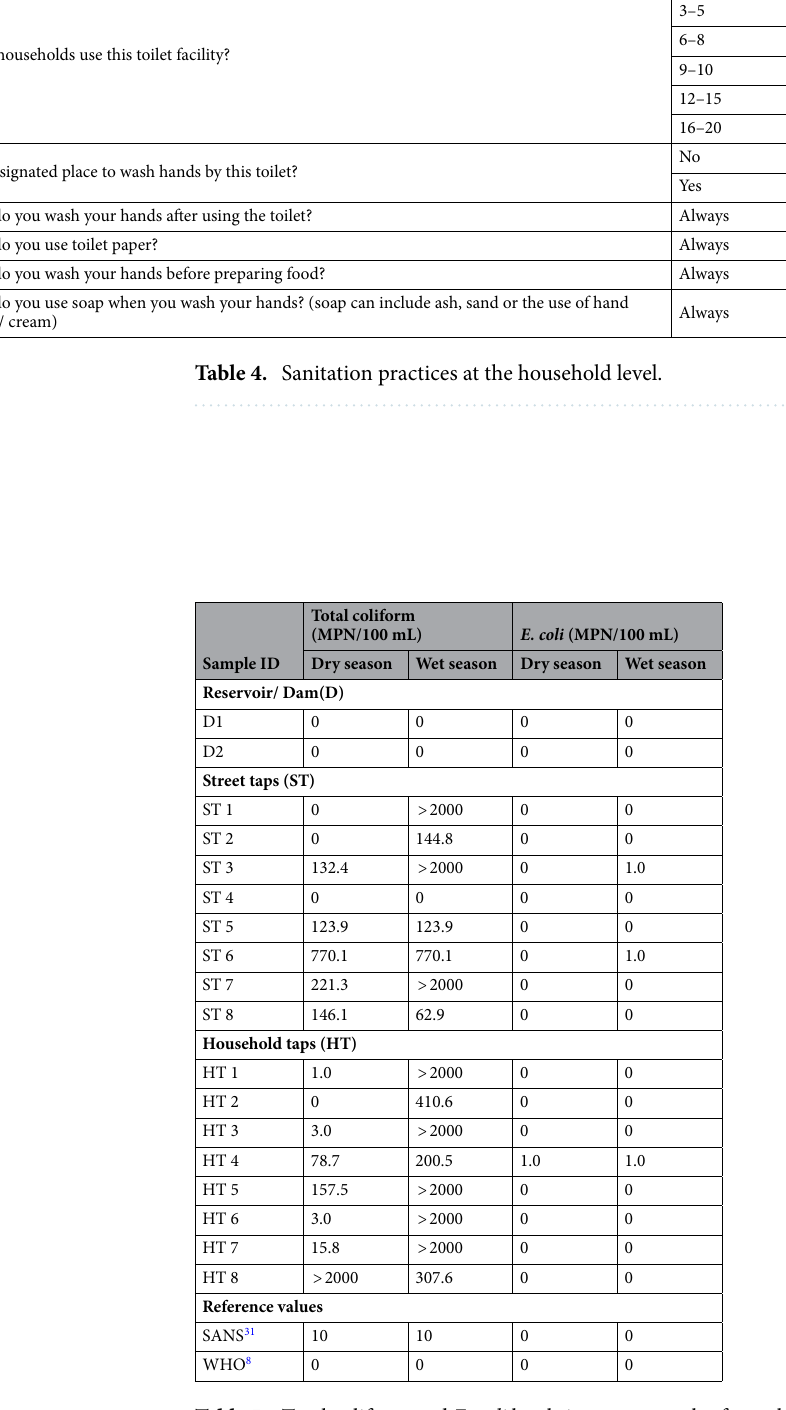
Table 5. Total coliform and E. coli levels in water samples from the reservoir, street taps and household